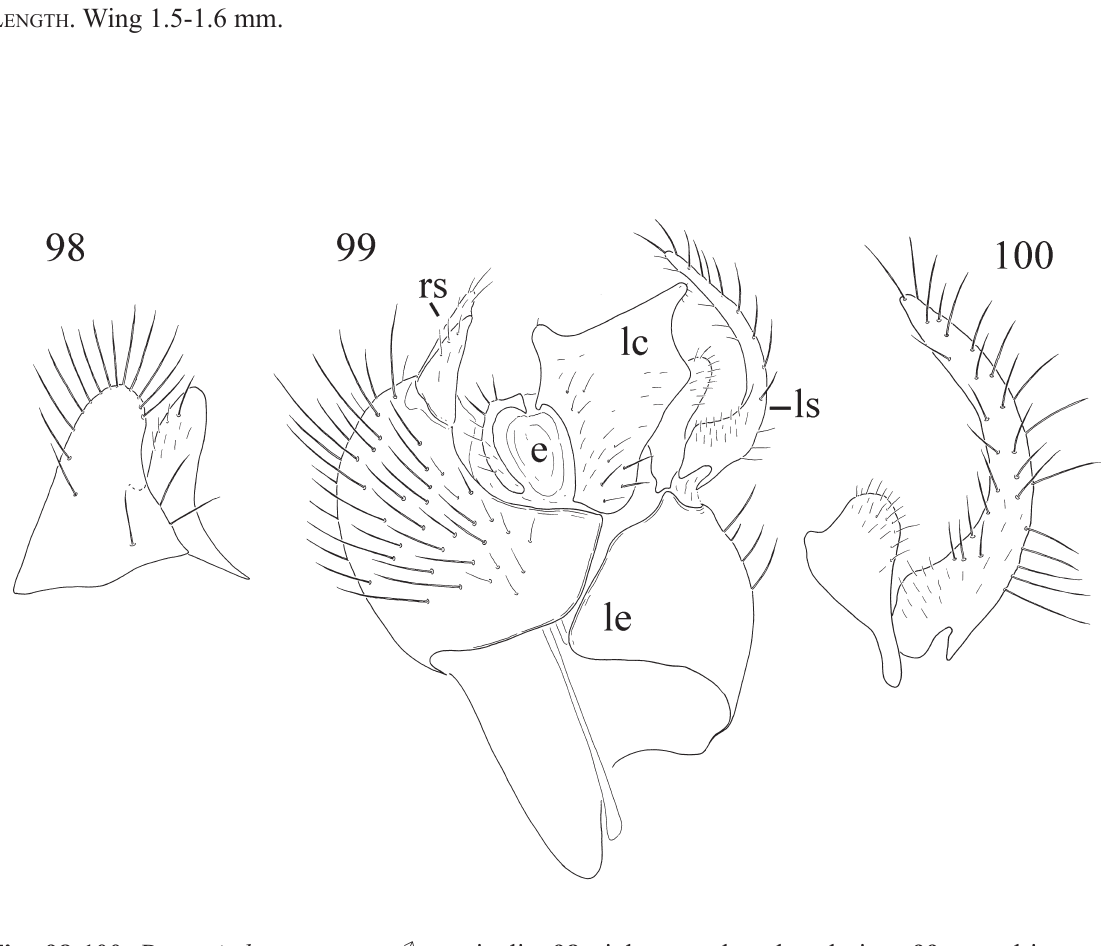
Figs 98-100. Drapetis laut sp. nov., ♂ terminalia. 98 . right surstylus, dorsal view. 99 . epandrium and cerci, dorsal view. 100 . left surstylus, lateral